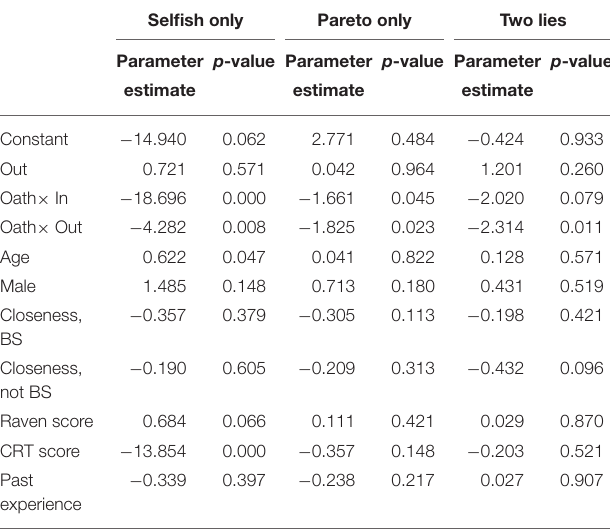
TABLE 2 | Parametric estimation of the treatment effects. Selfish only Pareto only Two